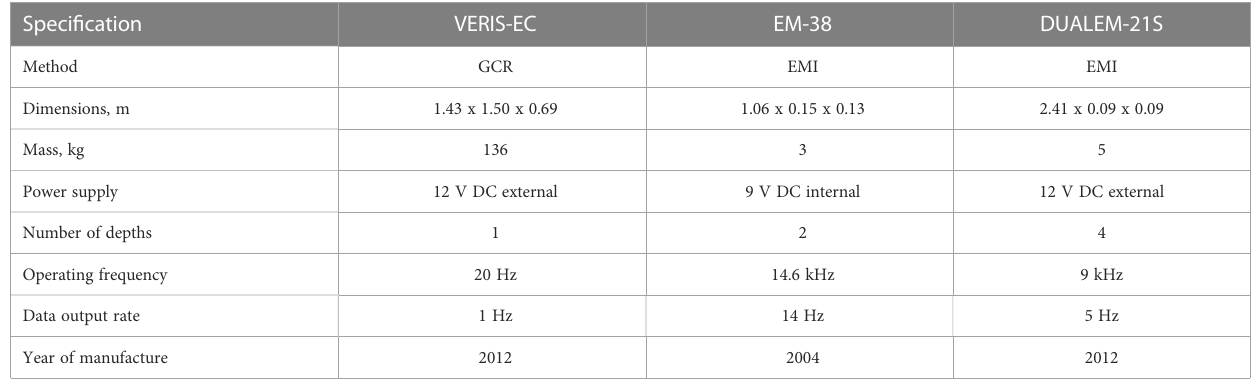
TABLE 1 Instrument speci fi cations.